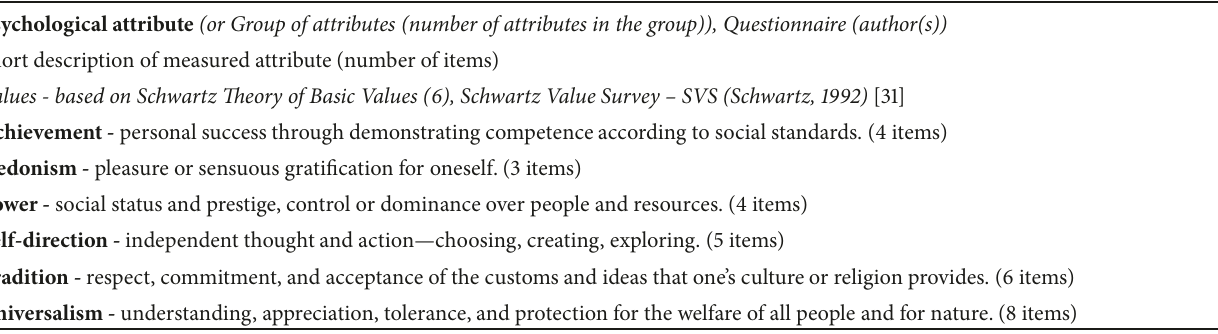
Table 1: Description of 26 psychological attributes included in the